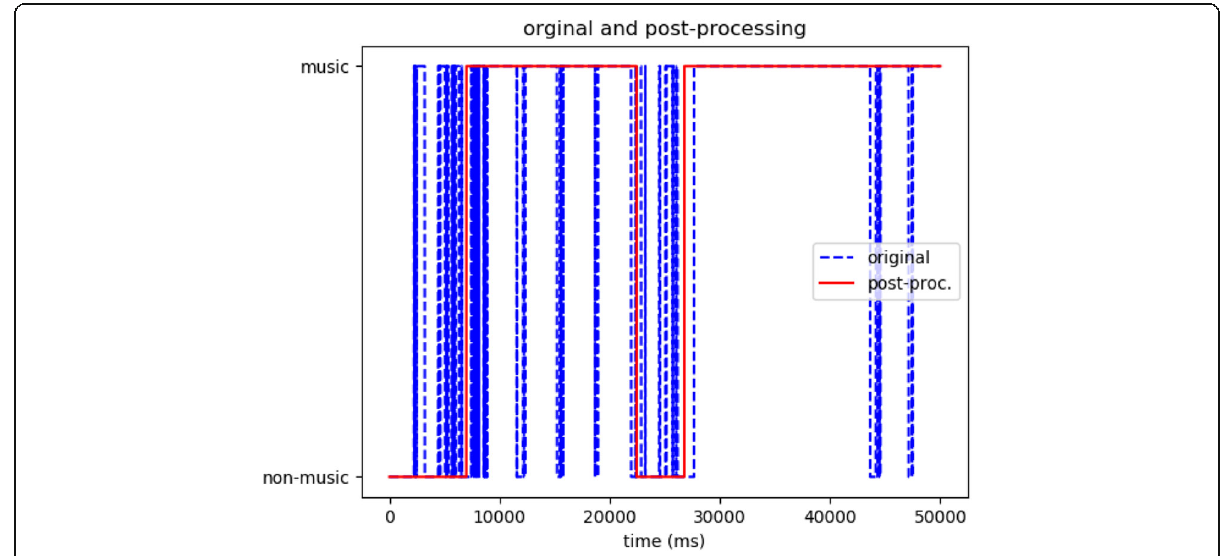
Fig. 7 Original and post-processing results